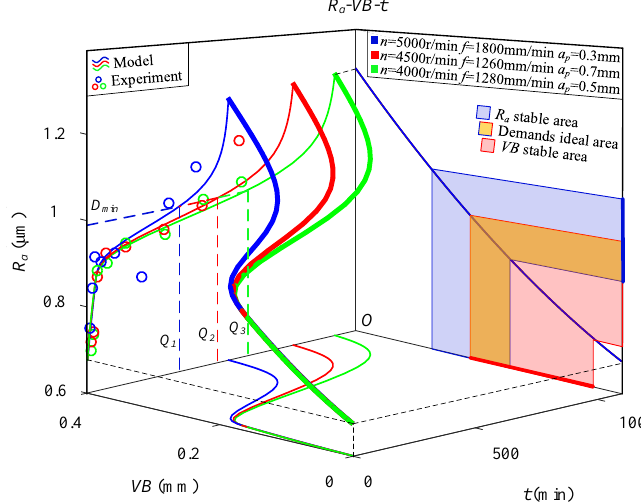
Figure 14. Derivation process of R a -VB relationship.